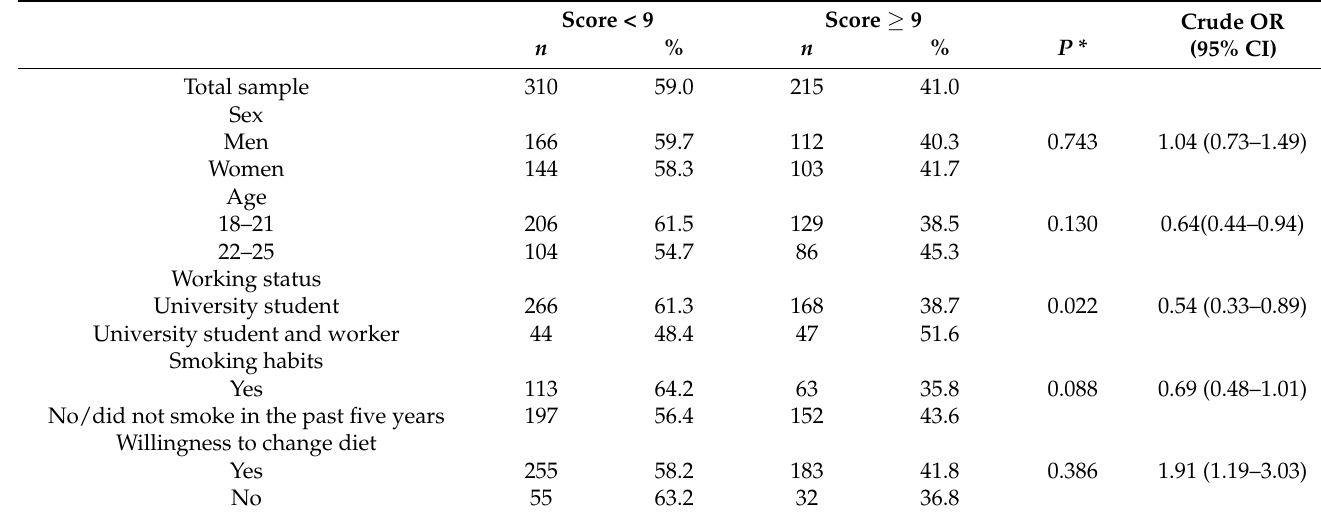
Table 3. Adequacy of adherence to MedDiet according to different